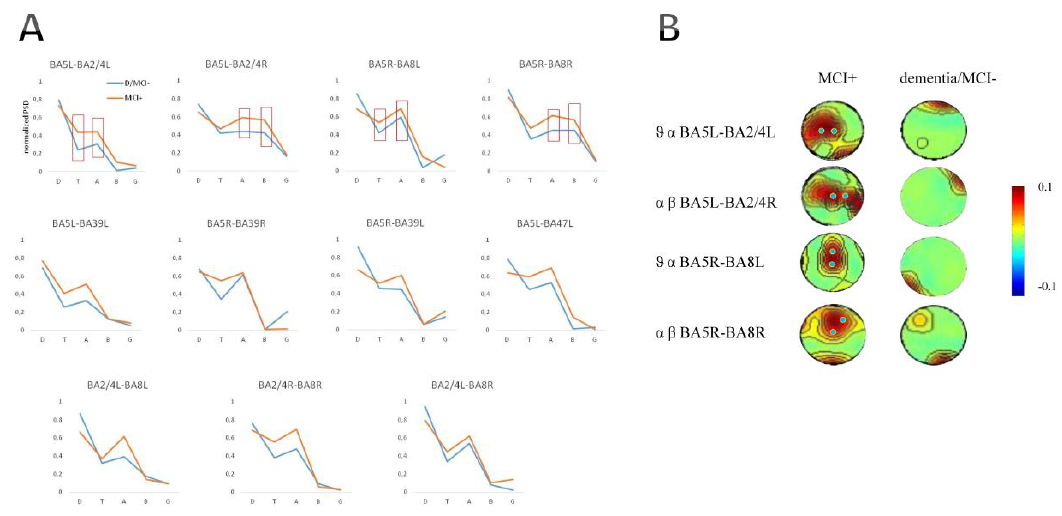
Figure 3. Spectral dynamics of post-pre iTBS resting-state networks. Panel A illustrates the power spectral density (PSD) (normalized by the spectral resolution employed to digitize the signal) of all the networks modified by iTBS, with peaks at the significant carrier frequencies (high-alpha and low-beta frequency range, 11–20Hz, and theta and low-alpha, 5–8Hz) (red boxes). Panel B plots the post-pre TBS di ff erence of topographic view of average iCoh values. Post-pre iTBS-induced changes in iCoh are coded in the color-bar (red-increase, blu-decrease). Values are interpolated for areas between electrodes at the significant carrier frequencies in the four significant edges (BA5L-BA2 / 4L; BA5L-BA2 / 4R; BA5R-BA8L; BA5R-BA8R). Table 2. Pre- and post-TBS phase spectra and Hurst exponent values of the four significant edges All post-TBS phase spectra increased significantly within the networks and frequency ranges (BA5L-BA2 / 4L; BA5L-BA2 / 4R; BA5R-BA8L; BA5R-BA8R) in patients with dementia (D) and MCI ( +/ -). mentioned afore (Table 2). In addition, the temporal evolution of connectivity among the W_p within-group post-pre p-value; B_p between-group post-pre abovementioned areas significantly changed, as estimated by the Hurst exponent (Table 2).